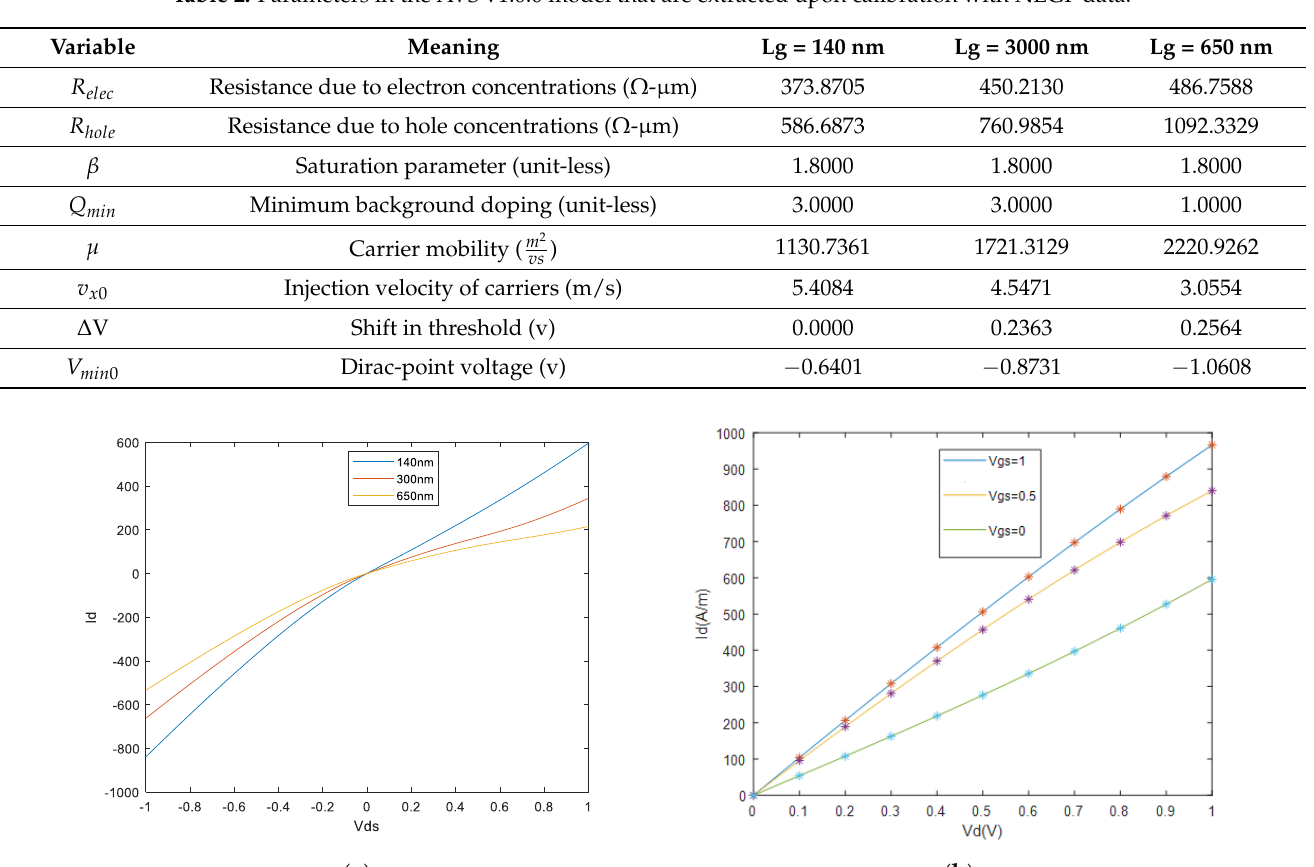
Table 2. Parameters in the AVS v1.0.0 model that are extracted upon calibration with NEGF data.